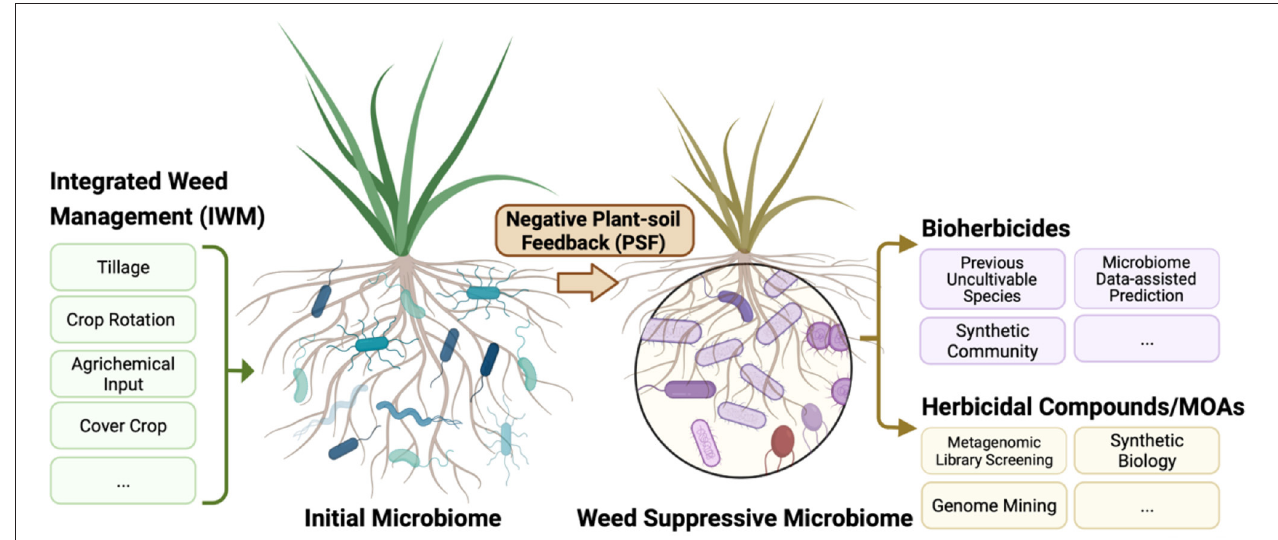
FIGURE 3 | A schematic overview of approaches harnessing the soil microbiome and negative plant-soil feedback to promote weed management in regenerative agriculture. Agricultural practices alter the soil microbiome, so practices that promote weed suppression by microorganisms could be included in integrated weed management programs. Negative plant-soil feedbacks occurs when plants cause biotic and abiotic changes in the soil, which inhibit further plant growth. Research on these feedback processes may help identify potential microbial agents or compounds involved in plant growth